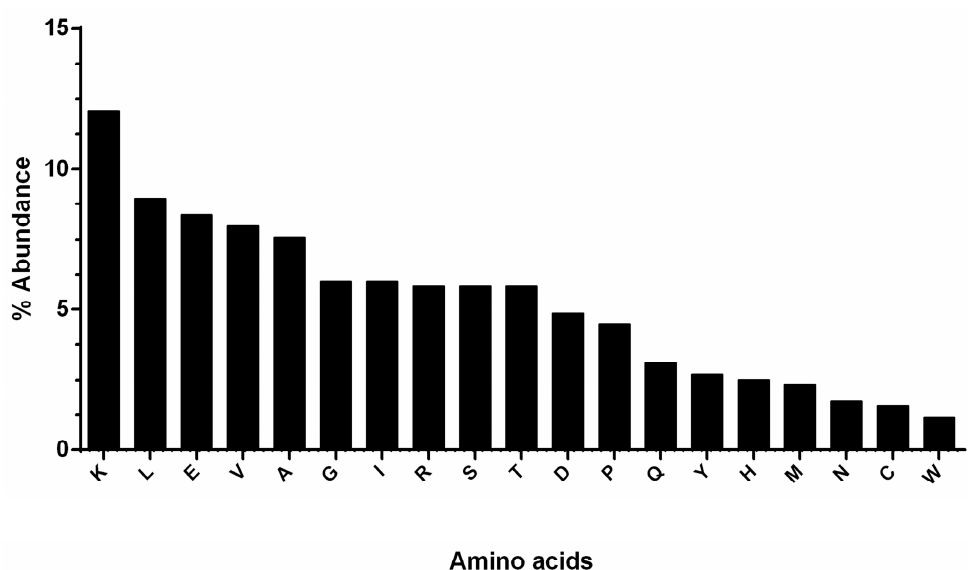
Figure 1. Graphical representation of the abundance of the 20 amino acids (aa) present in human dyskerin pseudouridine synthase (hDKC1). Lysine has the highest abundance, and phenylalanine has the lowest abundance.